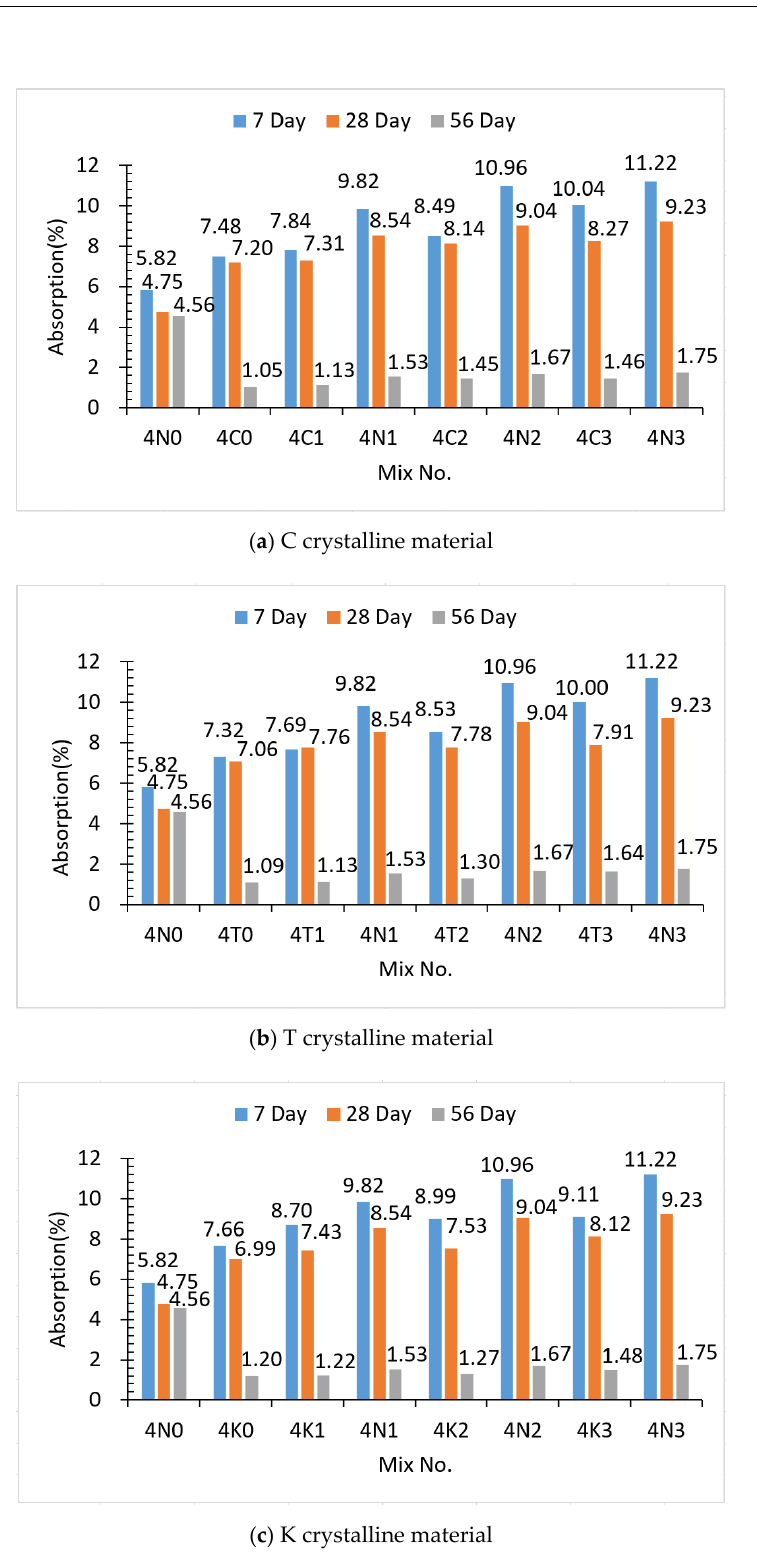
Figure 4. Saturated water absorption of cement mortar when W/C = 0.4.